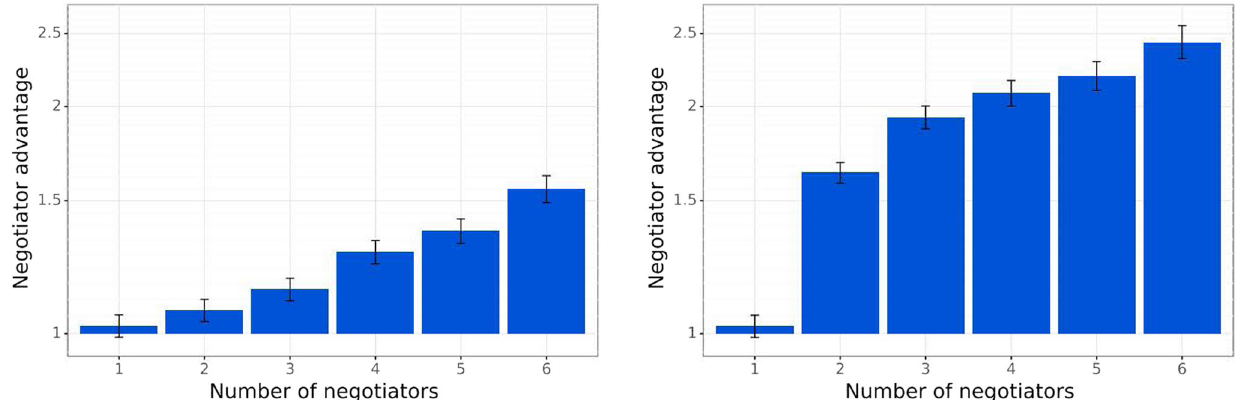
Fig. 4 | Baseline Negotiators outperform non-communicating agents. Left: Mutual Proposal protocol. Right: Propose-Choose protocol. The x axis is the number of communicating agents, and the y axis is the winrate advantage of the communicating agent over the baseline, expressed as a ratio W C W average winrate of the communicating agents and W N of the non-communicating agents, measured over 10,000 games. The advantage each communicating agent enjoys grows as there are more communicating peers to make agreements with.